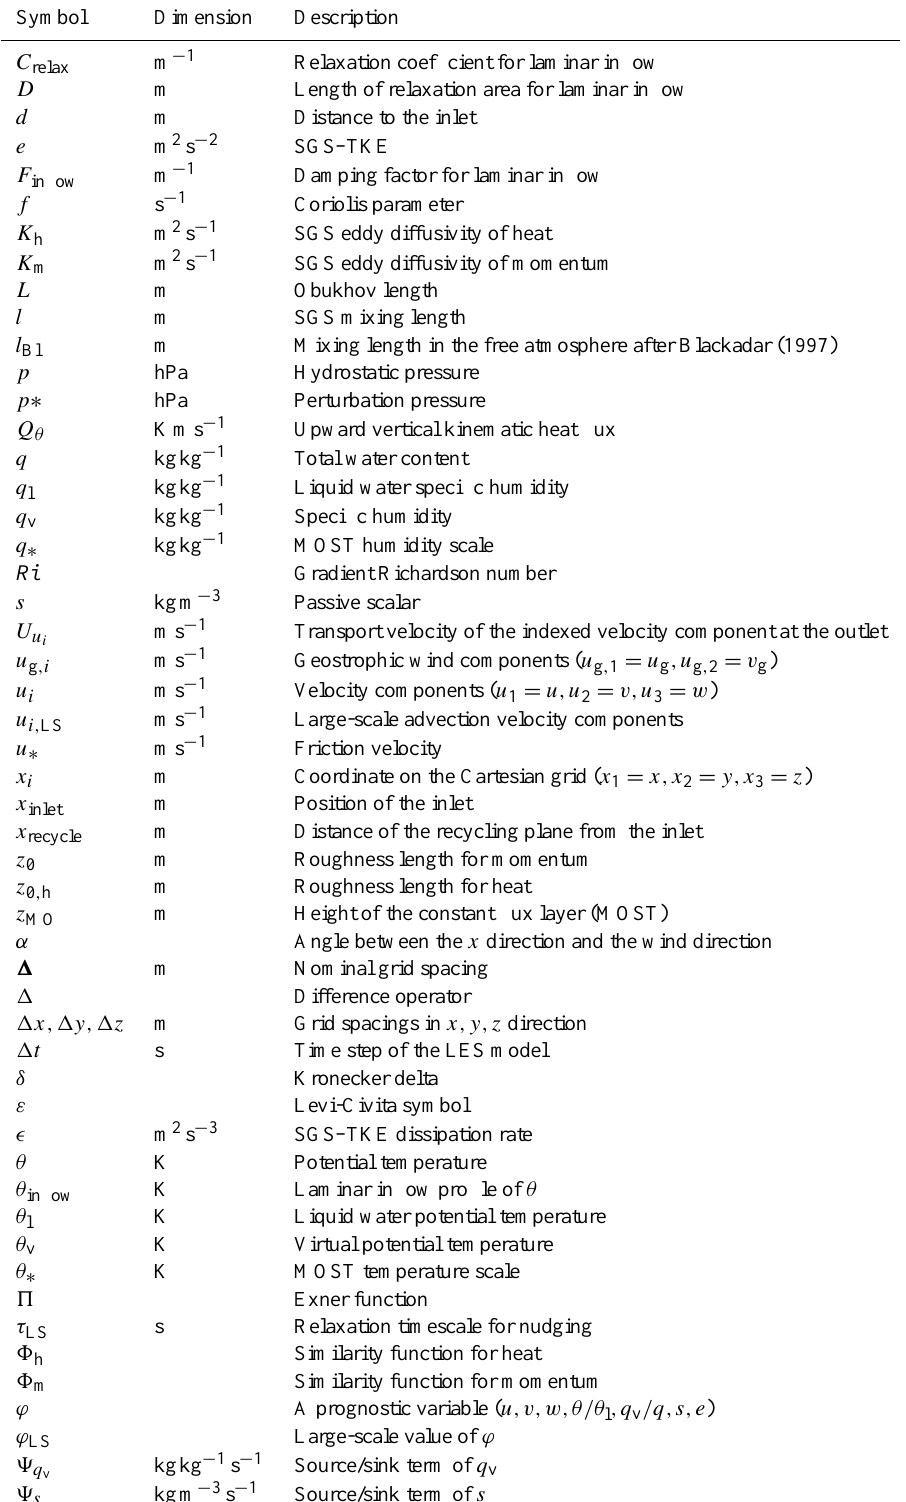
Table 2. List of general